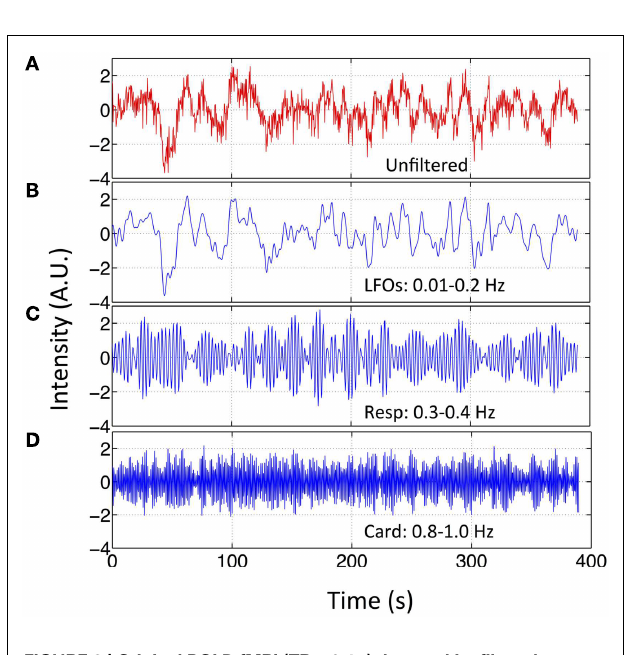
FIGURE 2 | Original BOLD fMRI (TR = 0.4s) data and its filtered versions .Temporal trace of the original BOLD data (in red) from resting state fMRI scan (TR = 0.4s) in (A) and its band-passed versions in (B) 0.01–0.2Hz; (C) 0.3–0.4Hz; and (D)